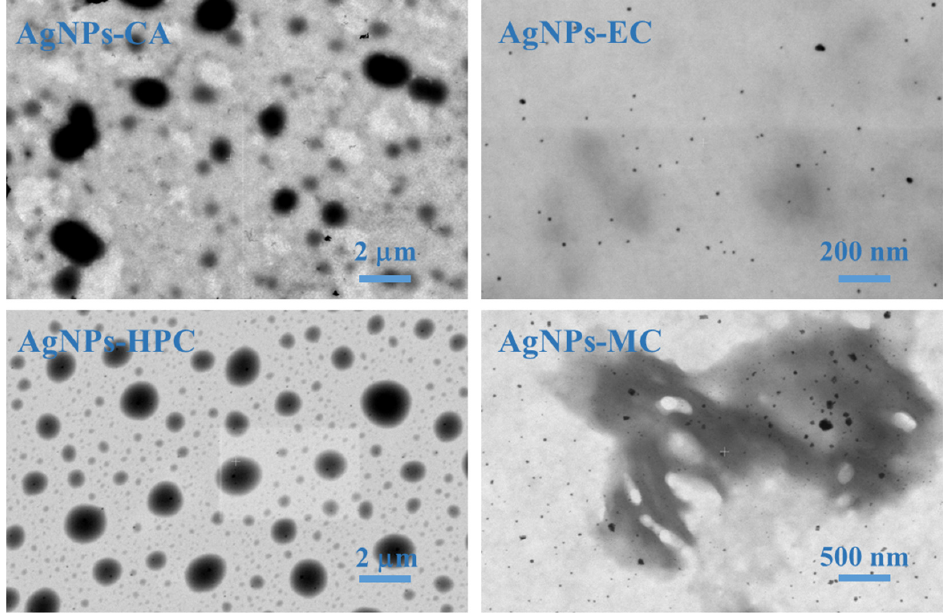
Figure 4. STEM images of the AgNPs synthesized from cellulose derivatives.